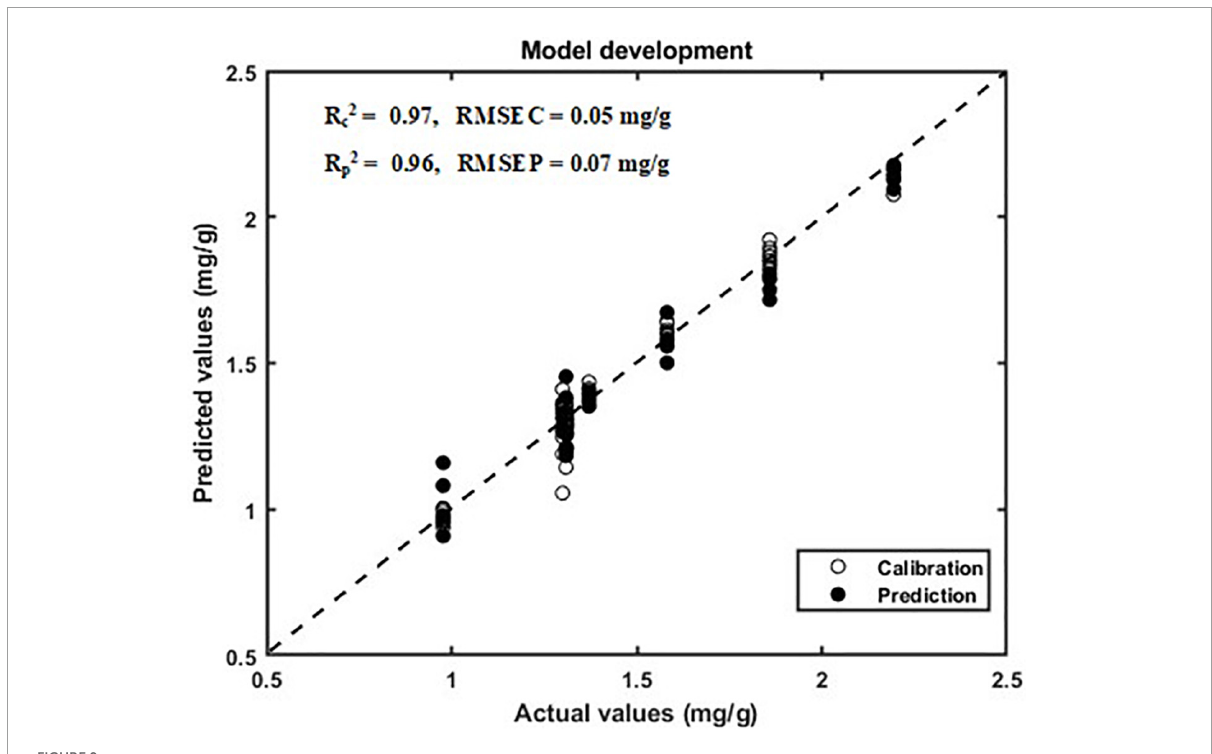
FIGURE9 Prediction plot of total phenolic compounds in plants under various stress conditions.